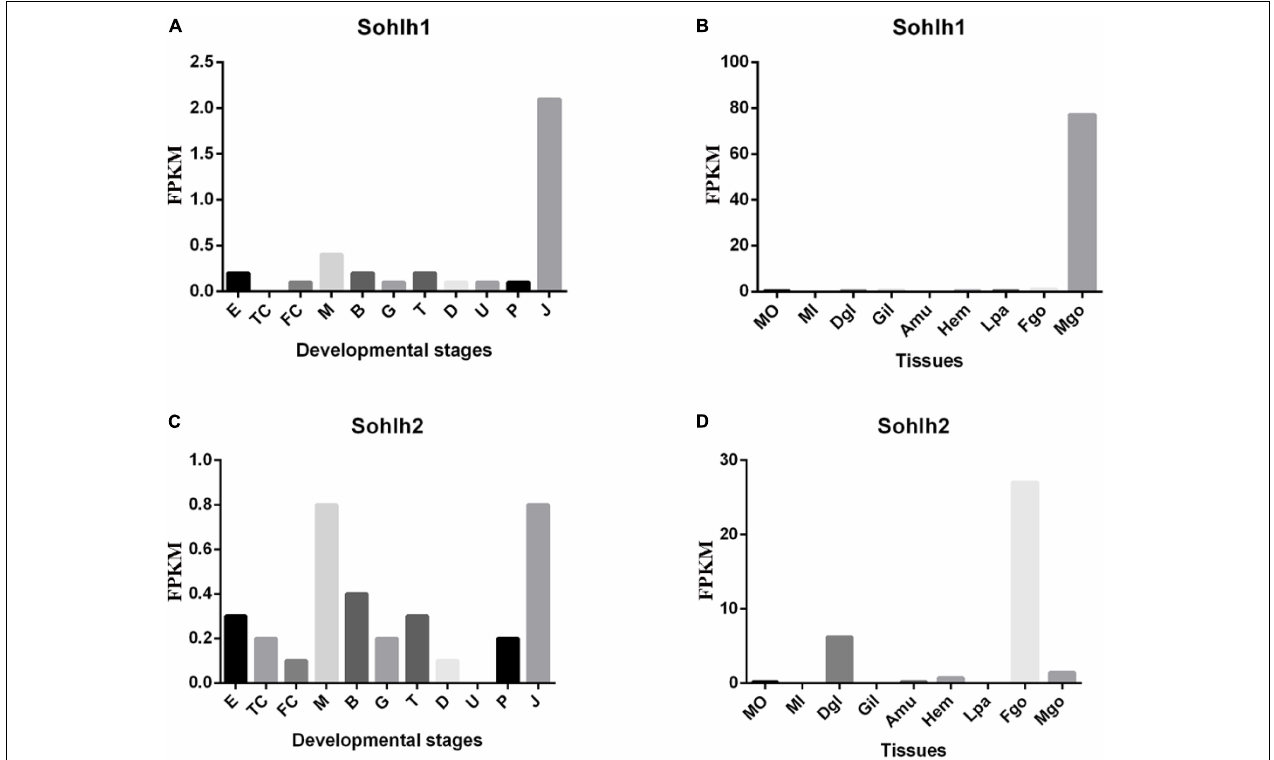
FIGURE 3 | Transcriptional expression of Cg-sohlh in developmental stages (A,C) and adult tissues (B,D) . (A,C) The indicated developmental stages are described as follow. E, egg; TC, two cells; FC, four cells; M, morula; B, blastula; G, gastrula; T, trochophore; D, D-larva; U, umbo larva; P, pediveliger; and J, juvenile; B and D, organs are abbreviated as follow. Mo, the outer edge of mantle; Mi, the inner pallial of mantle; Dgl, digestive gland; Gil, gills; Amu, adductor muscle; Hem, hemocyte; Lpa, labial palp; Fgo, female gonad; Mgo, male gonad.